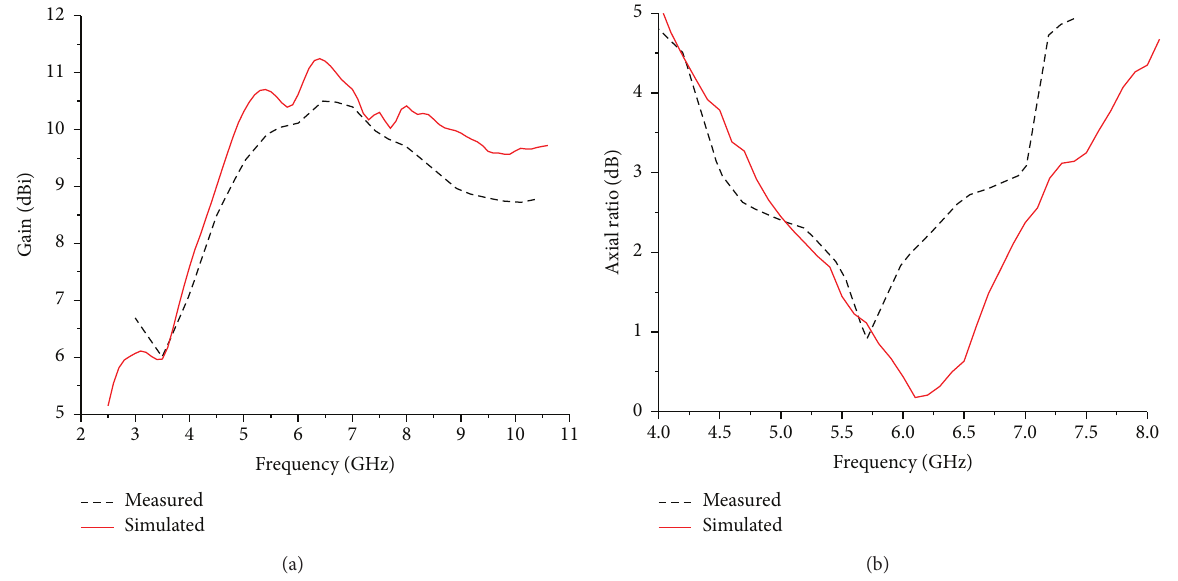
Figure 10: (a) The gain of the LP Vivaldi antenna element and (b) the axial ratio of the CP antenna